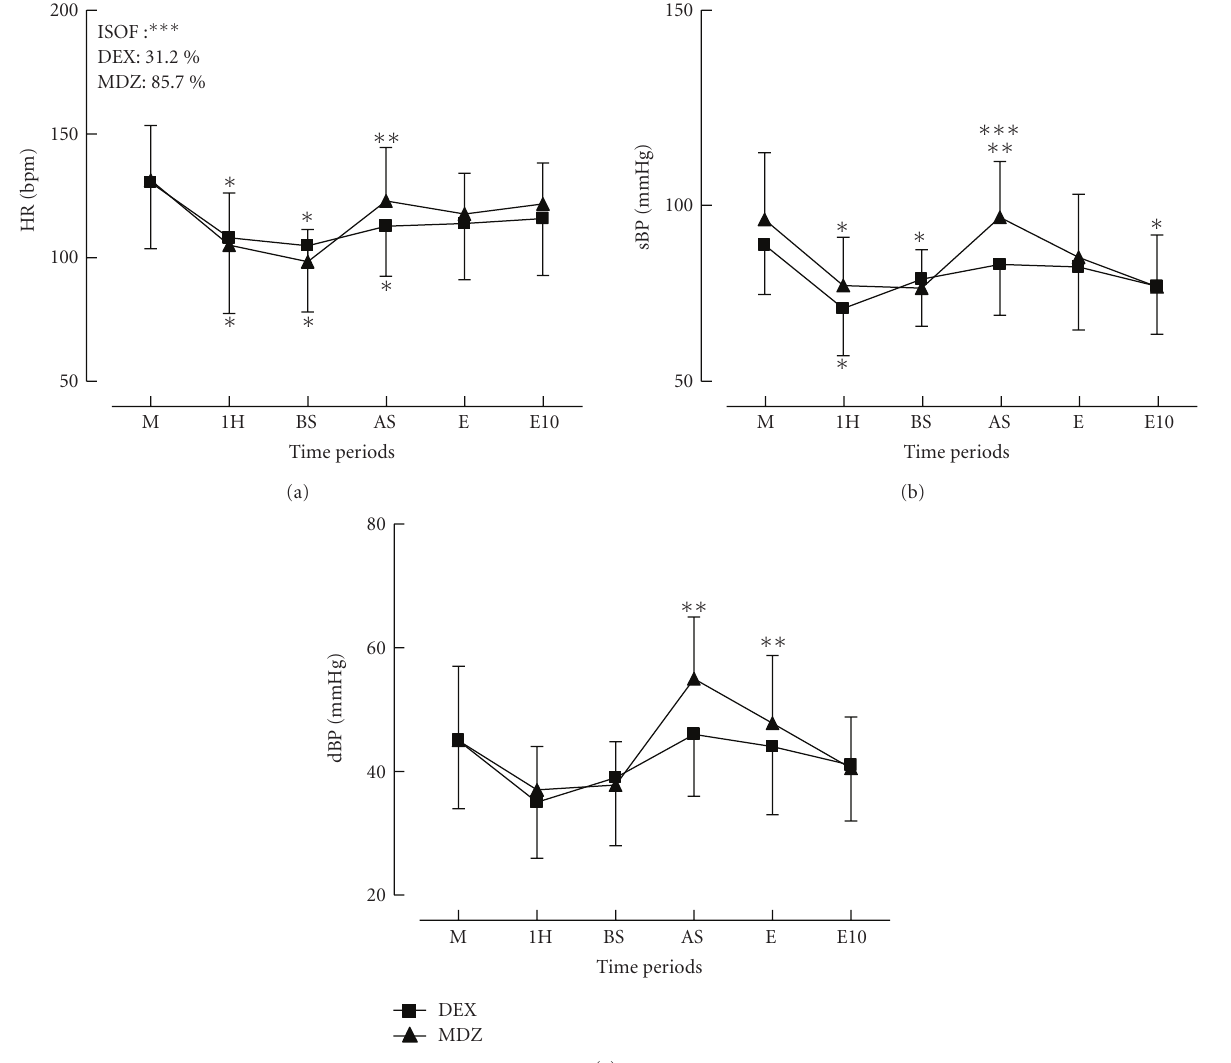
Figure 1: E ff ects of dexmedetomidine (DEX) on heart rate (HR) and diastolic (dBP) and systolic blood pressure (sBP) during cardiac surgery with CPB in children. M: after midazolan (MDZ) 0.2 mg · kg − 1 , 1H: after one hour of infusion of DEX (1 μ g · kg − 1 ) or MDZ (0.2mg · kg − 1 ) associated with fentanyl (10 μ g · kg − 1 ), BS: before skin incision, AS: after skin incision, E: after sternotomy, E10: 10 minutes after sternotomy. The box represents the number of patients that required isoflurane after skin incision. Data represent mean ± SD. ∗ Significantly di ff erent from ∗ M, from ∗∗ BS, and ∗∗∗ between